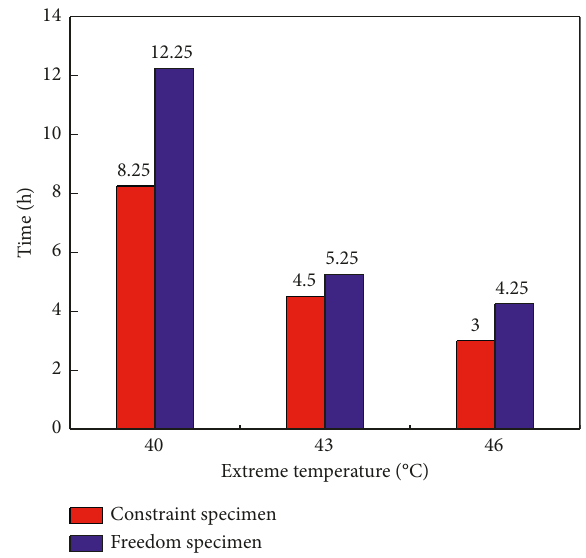
Figure 7: Time required to raise the temperature to 38 °